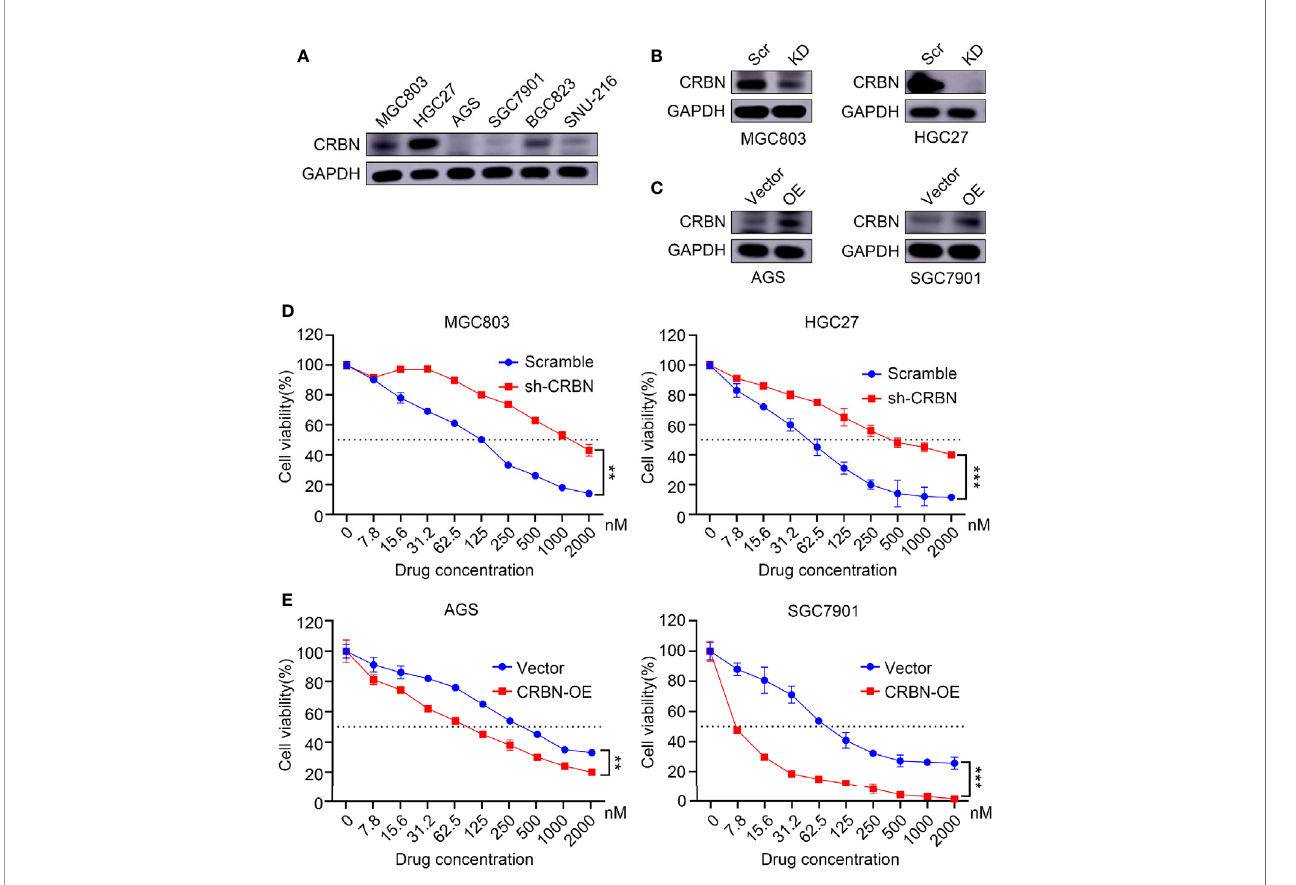
FIGURE 4 | CRBN performs an important role in response to ARV-825 in gastric cancer cells. (A) CRBN protein levels in gastric cancer cells by Western blotting analysis. (B) Western blotting analysis showing CRBN protein level after knockdown CRBN by sh-CRBN lentivirus in MGC803 cells and HGC27 cells. KD, knockdown, Scr, Scramble. (C) Western blotting analysis showing CRBN protein level after overexpressing CRBN in AGS cells and SGC7901 cells. OE, overexpression. (D) Cells of knockdown CRBN increased cell viability after treated with ARV-825 in MGC803 cells and HGC27 cells. (E) Cells of overexpressing CRBN decreased cell viability after treated with ARV-825 in AGS cells and SGC7901 cells. ** p < 0.01, *** p <